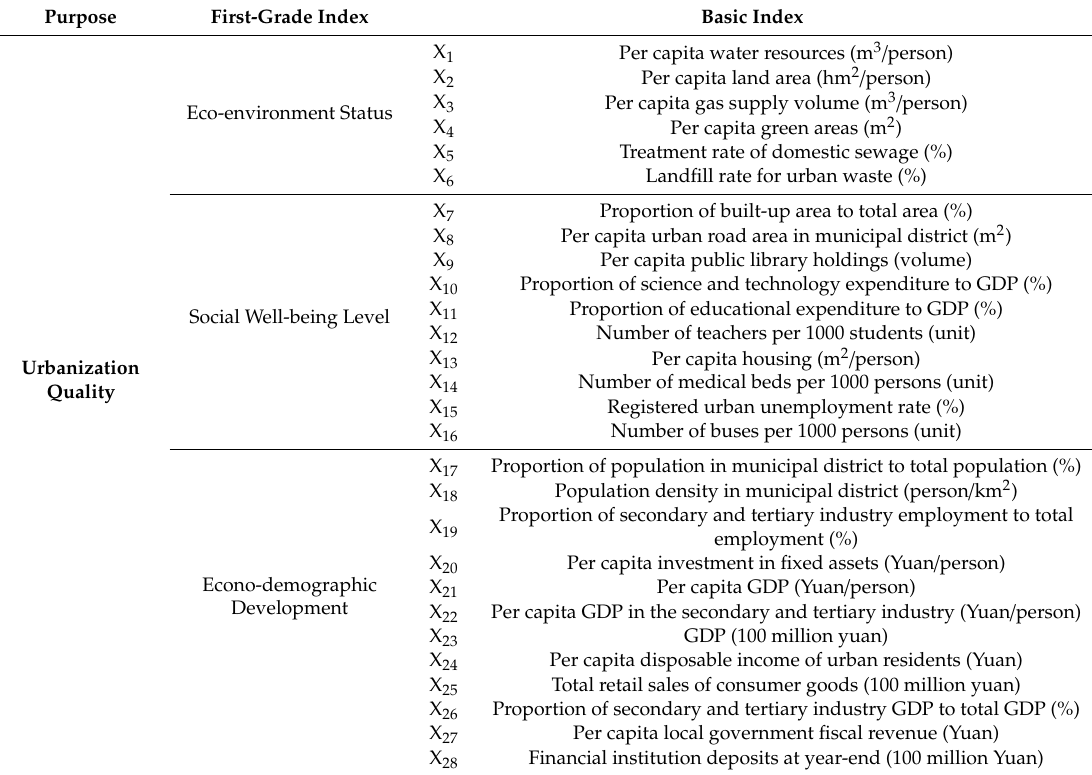
Table 2. Evaluation indicator system of urbanization